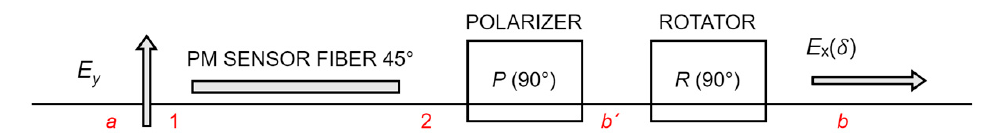
Figure 2. Arrangement of path a : a → 1 → 2 → b ’ → b .